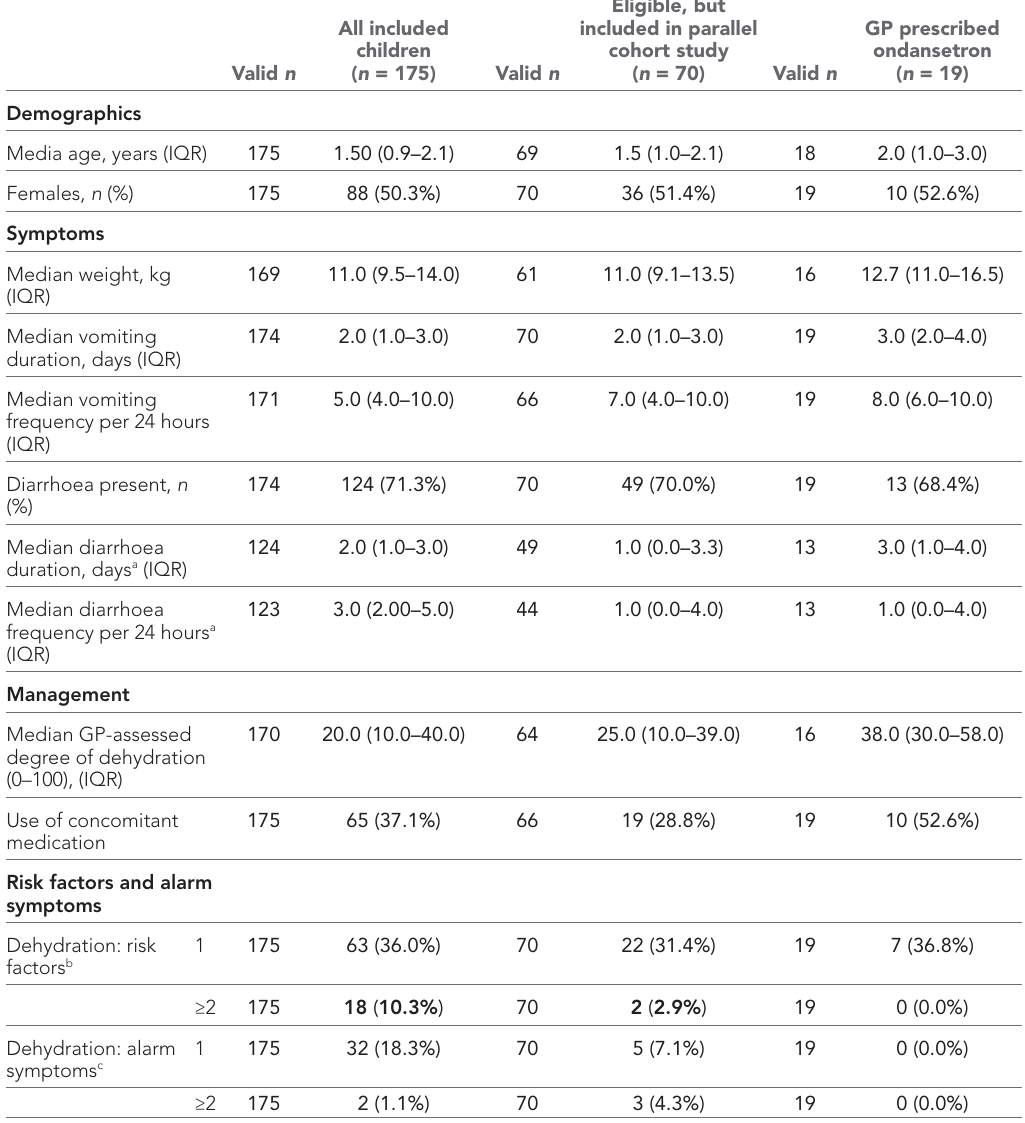
Table 2 Baseline characteristics of all children, and those in each analysed subgroup of children